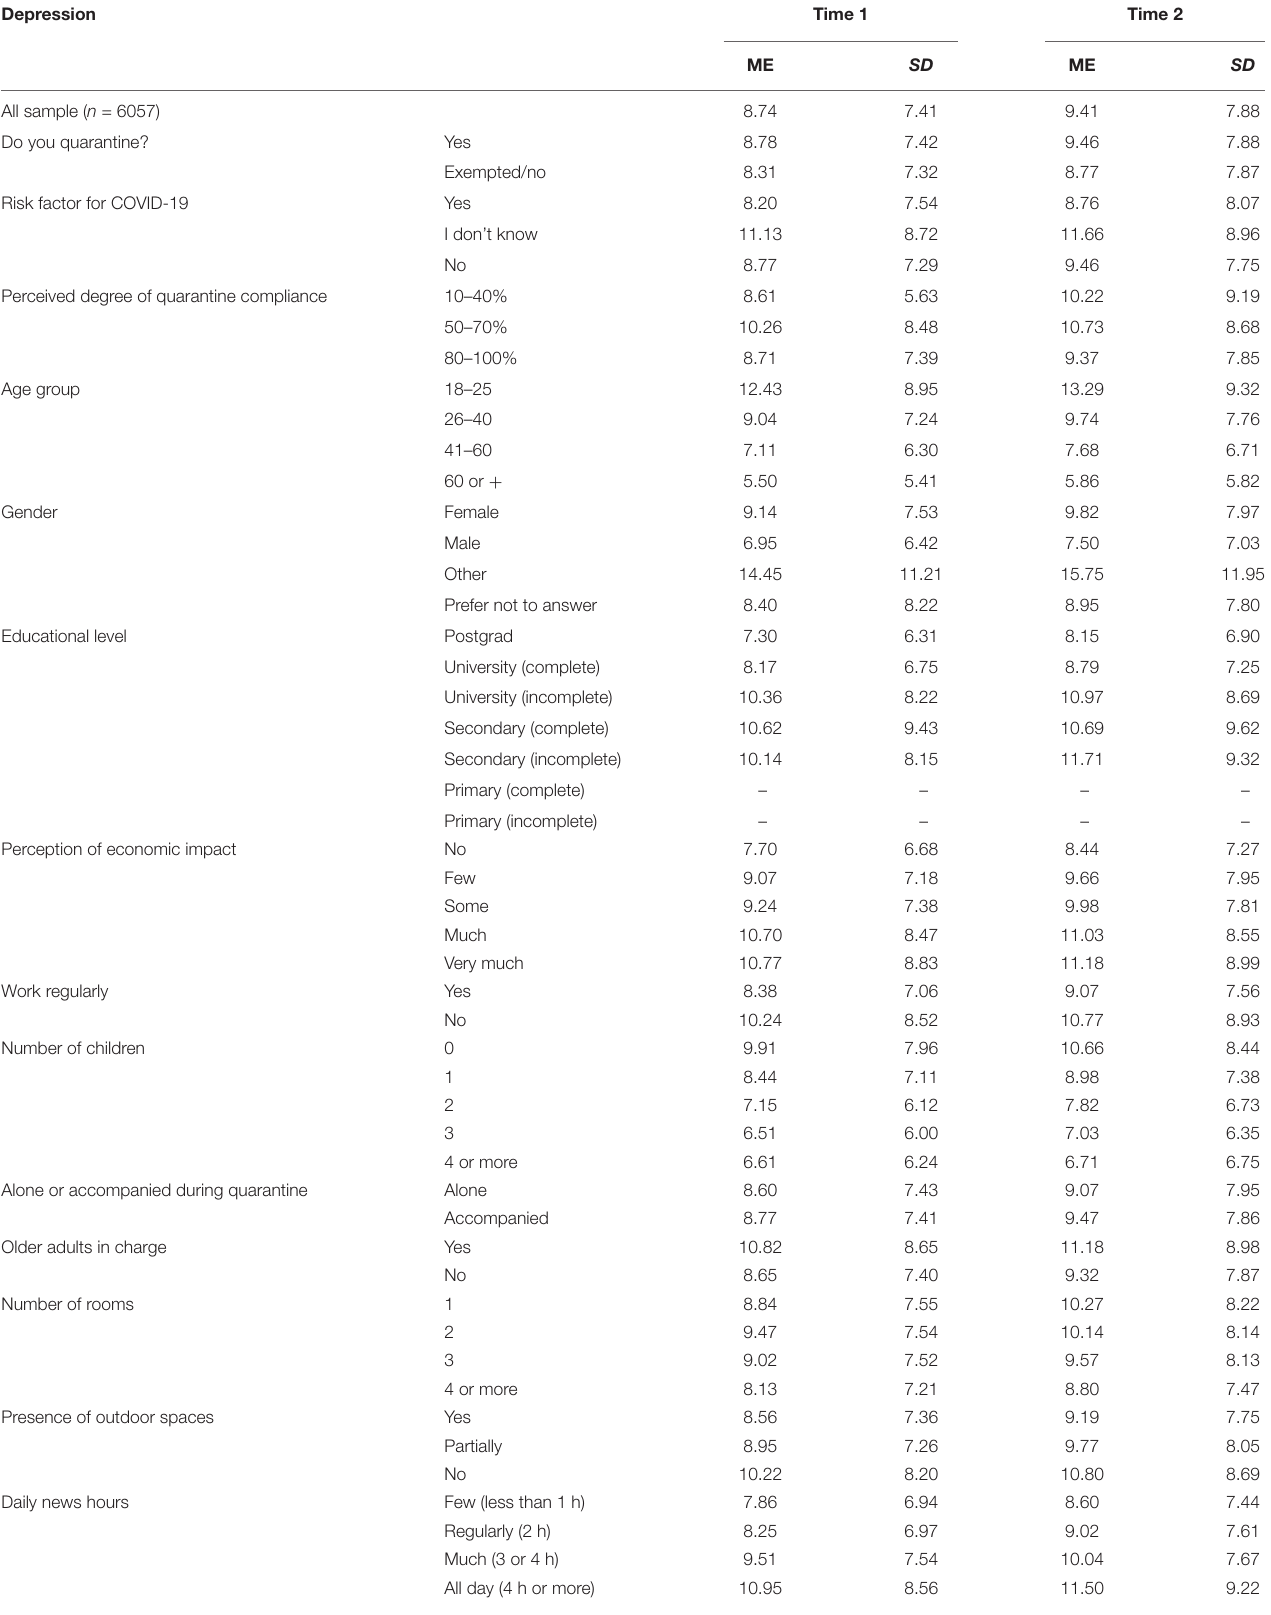
TABLE 2 | Descriptive statistics for depressive symptoms in Time 1 and Time 2.